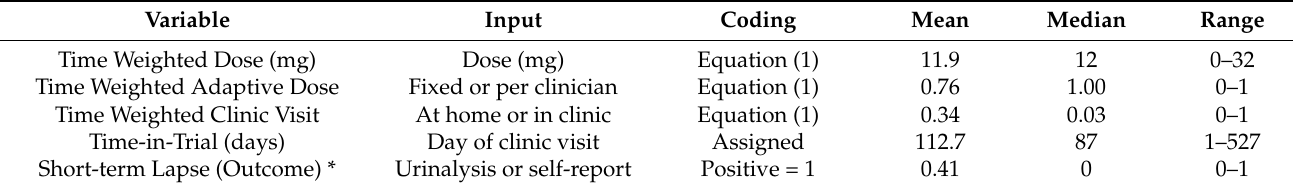
Table 1. Treatment and Outcome Variables in N = 3022